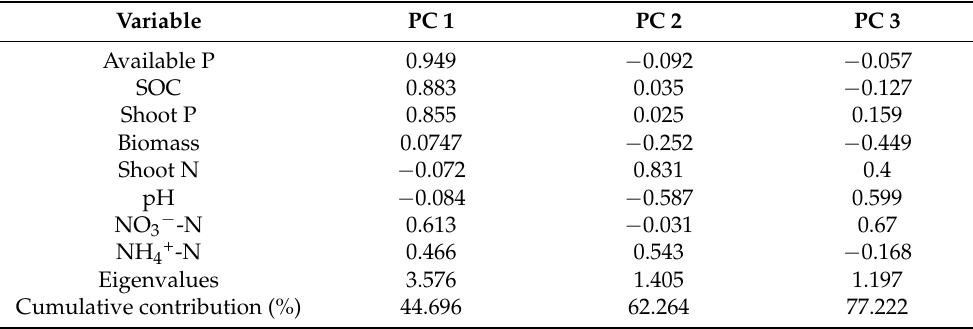
Table 3. Principal component analysis of soil quality